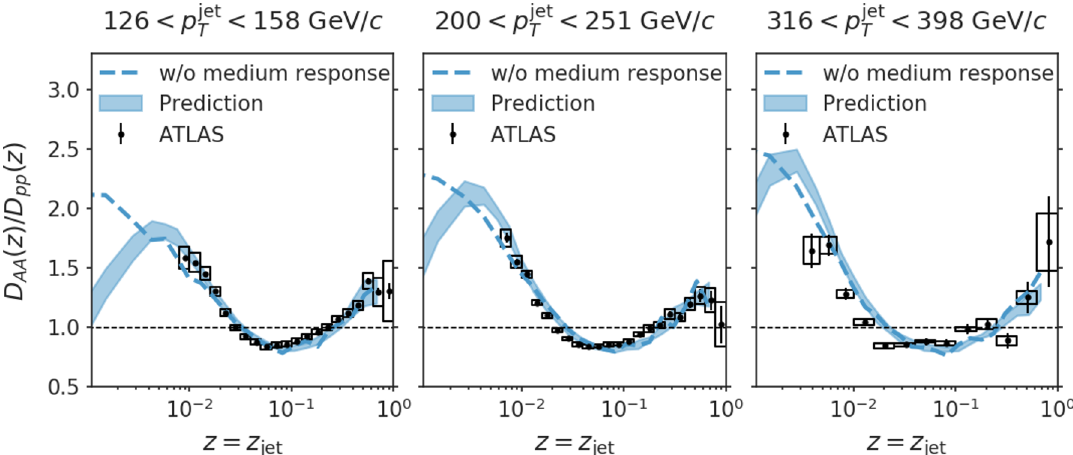
Figure 10 . Prediction of modification to the jet fragmentation function ( D ( z ) ) and comparison to ATLAS measurements for three different p jet bins [108]. Bands corresponds to the envelop T of calculations using the parameter sets listed in table 1. Dashed lines are calculations using the central parameter set but excluding contributions from medium excitations when calculating fragmentation